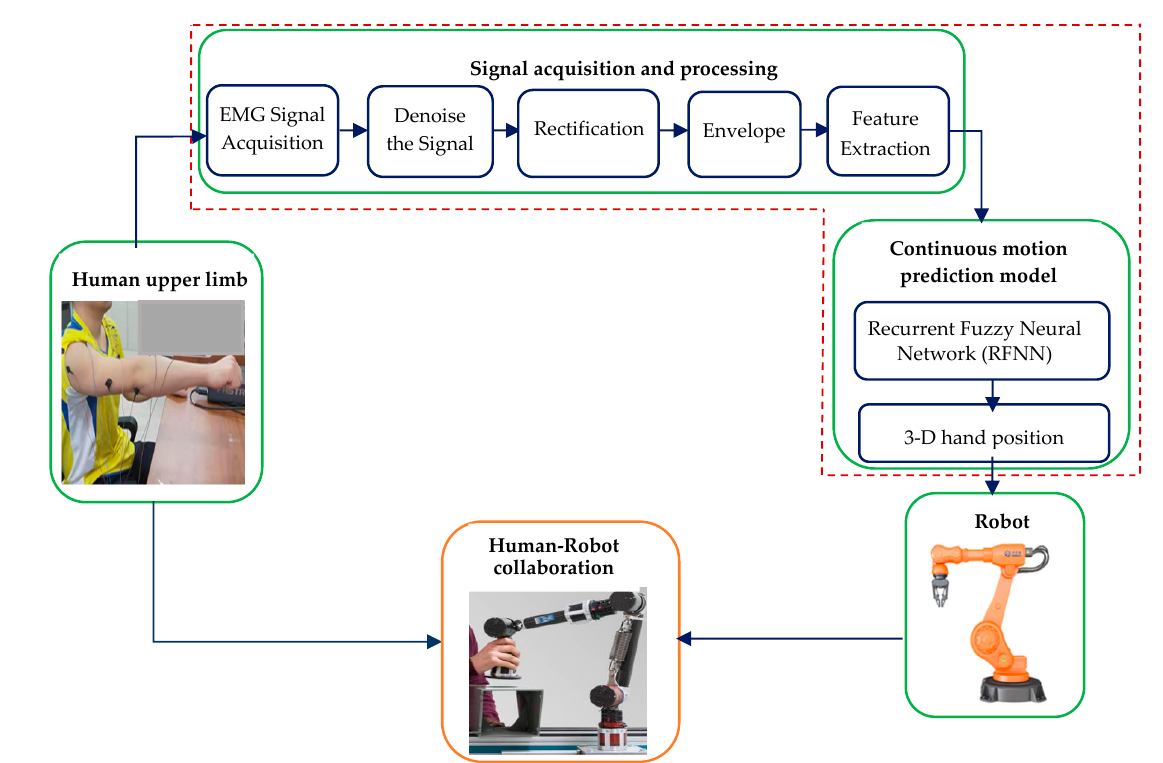
Figure 2. Electromyography (EMG)-based intention prediction of continuous human upper limb motion for human–robot collaboration systems.